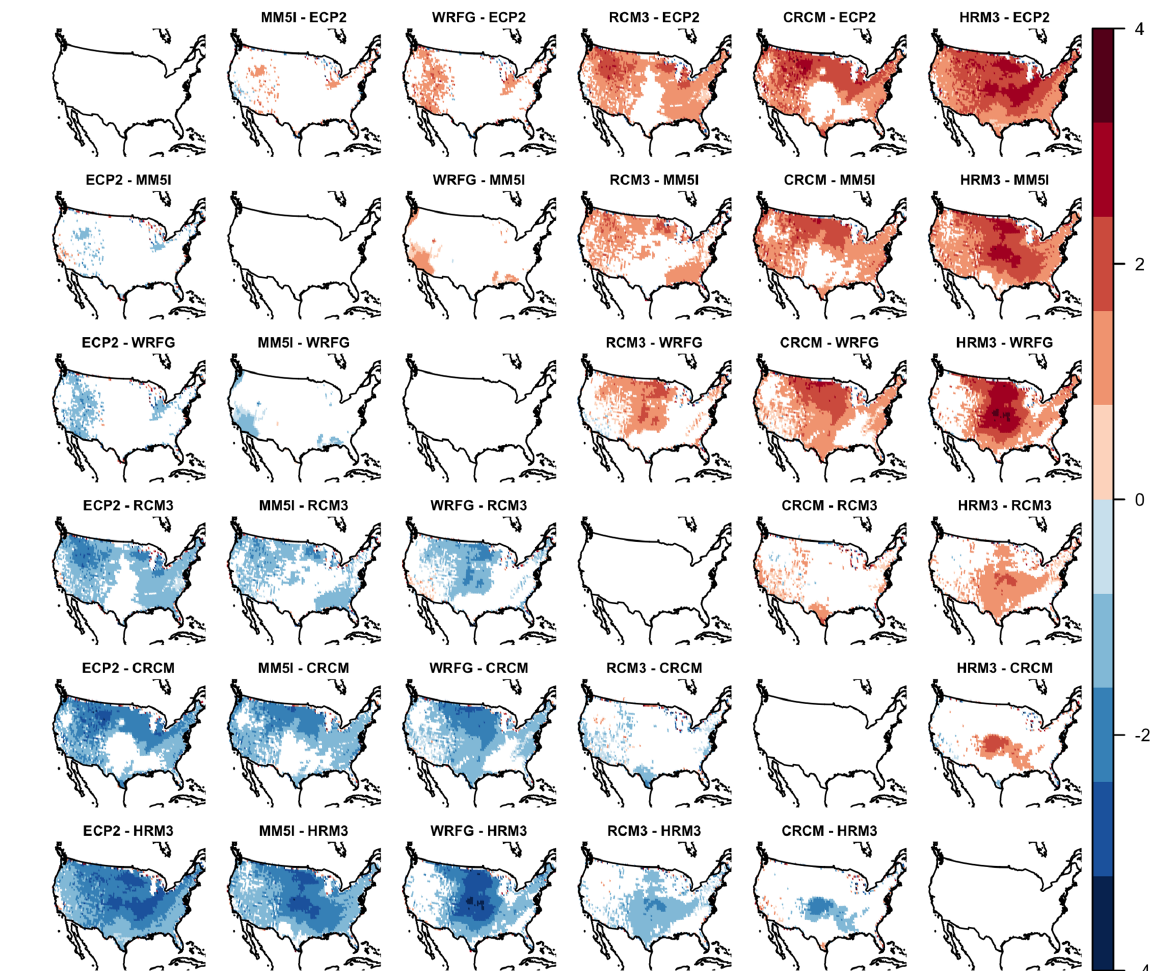
Figure 7. A heat map of the estimated average pairwise differences in RCM effect for the APL model. Only significant locations at the 0.10 level using the CoPE method are